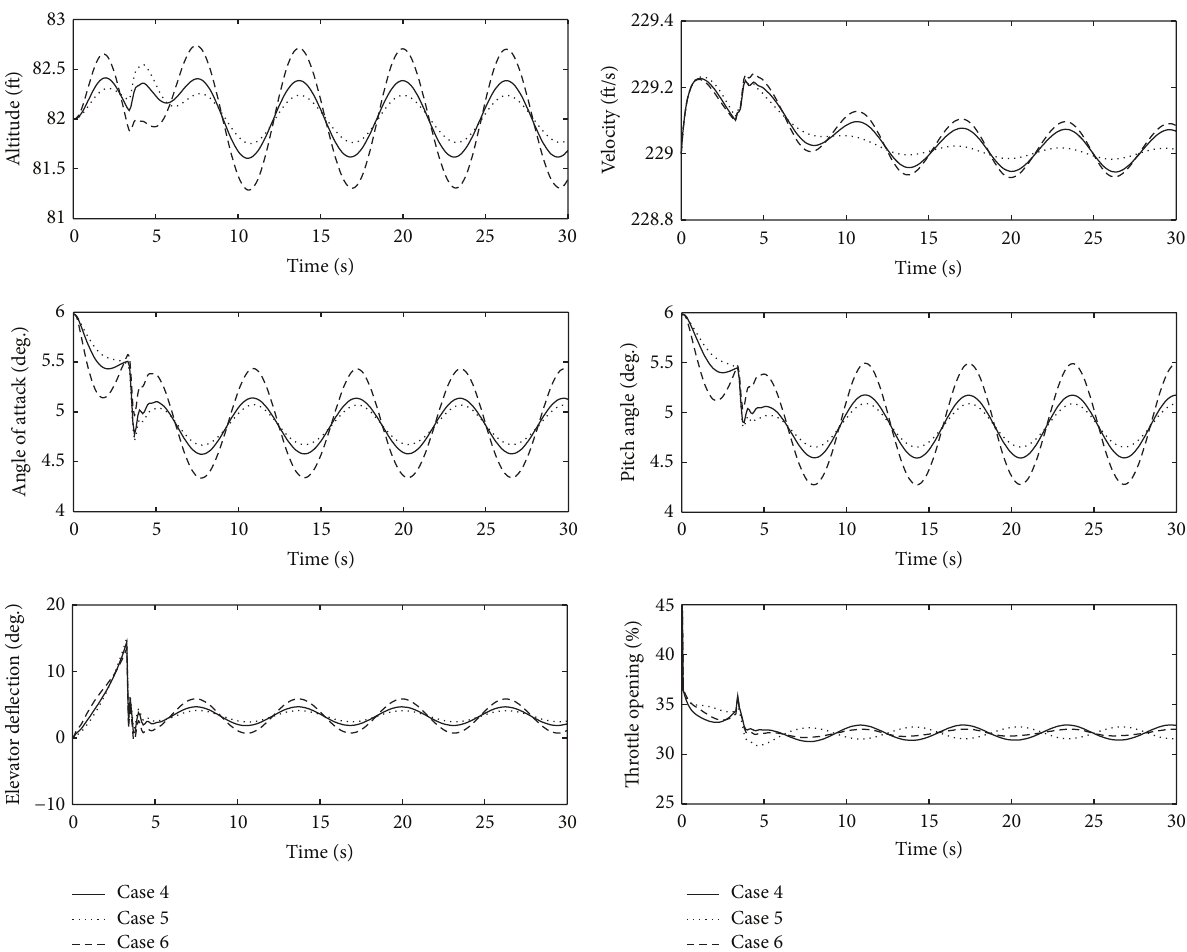
Figure 3: Aircraft responses of the dropping process in the presence of time-varying disturbances and uncertainties (Cases 4, 5, and 6).